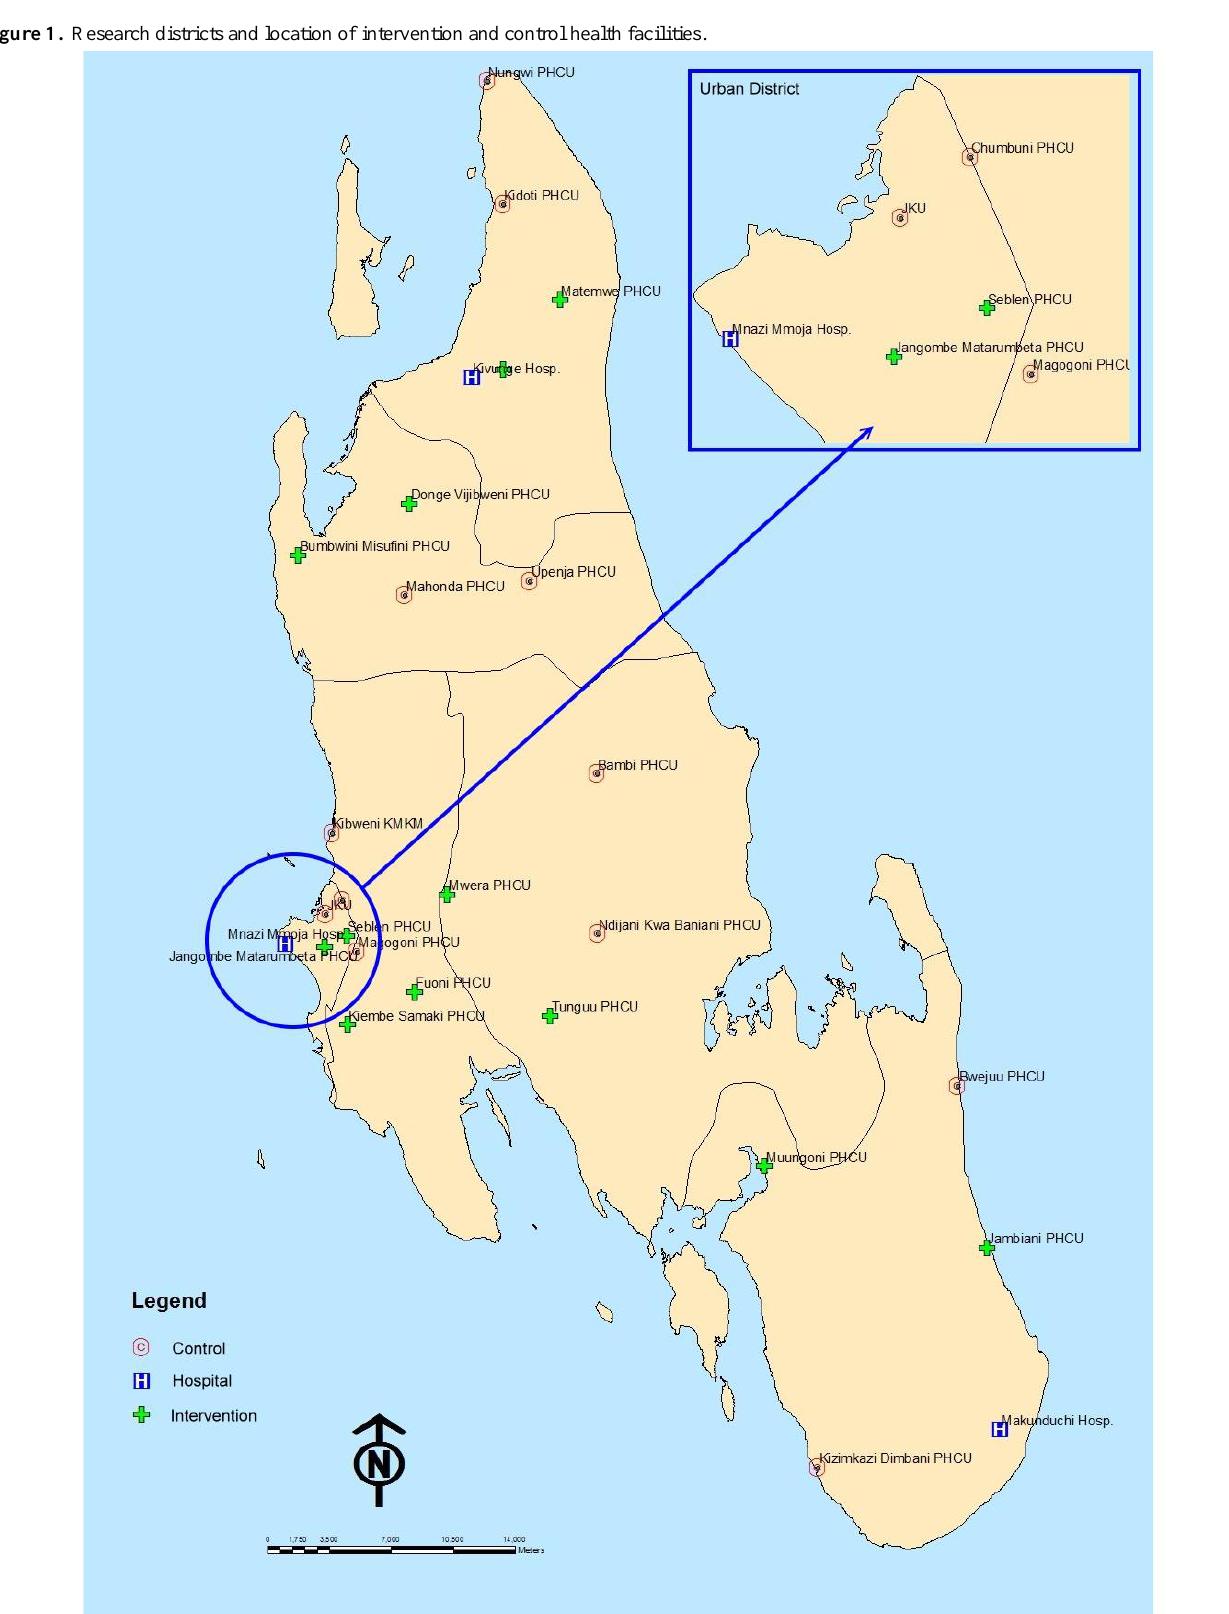
Figure 1. Research districts and location of intervention and control health